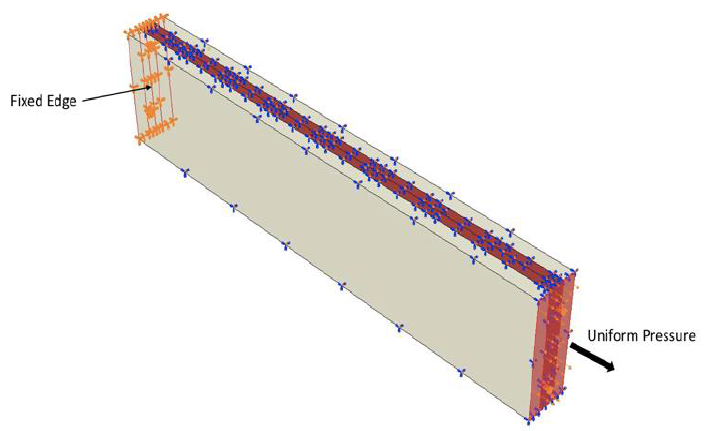
Figure 6 . 3D and zoomed 2D view of model having dual-sinusoidal optical fiber alignment.